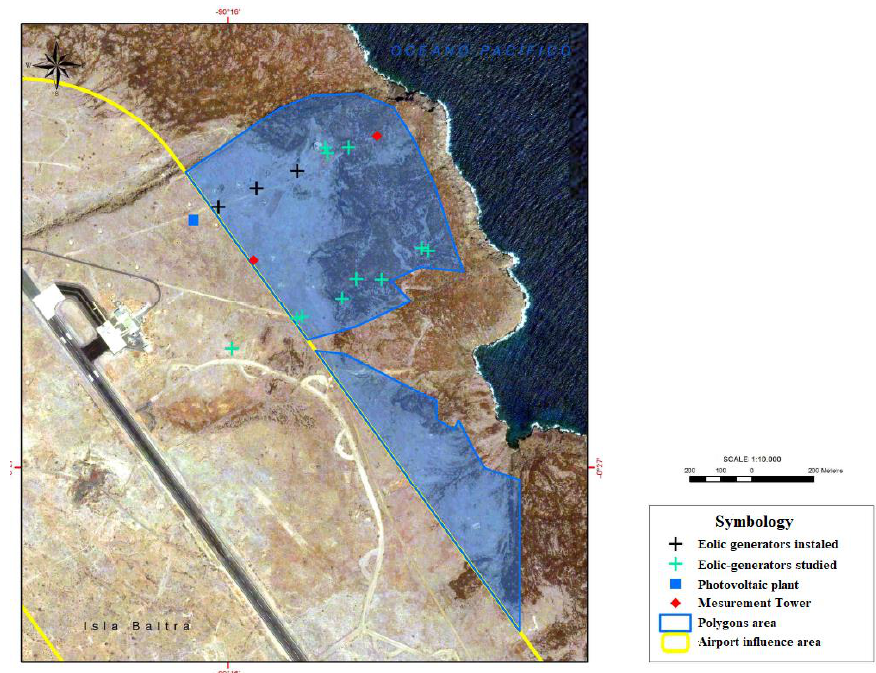
Figure 10. Polygons 1 and 2 on Baltra Island.